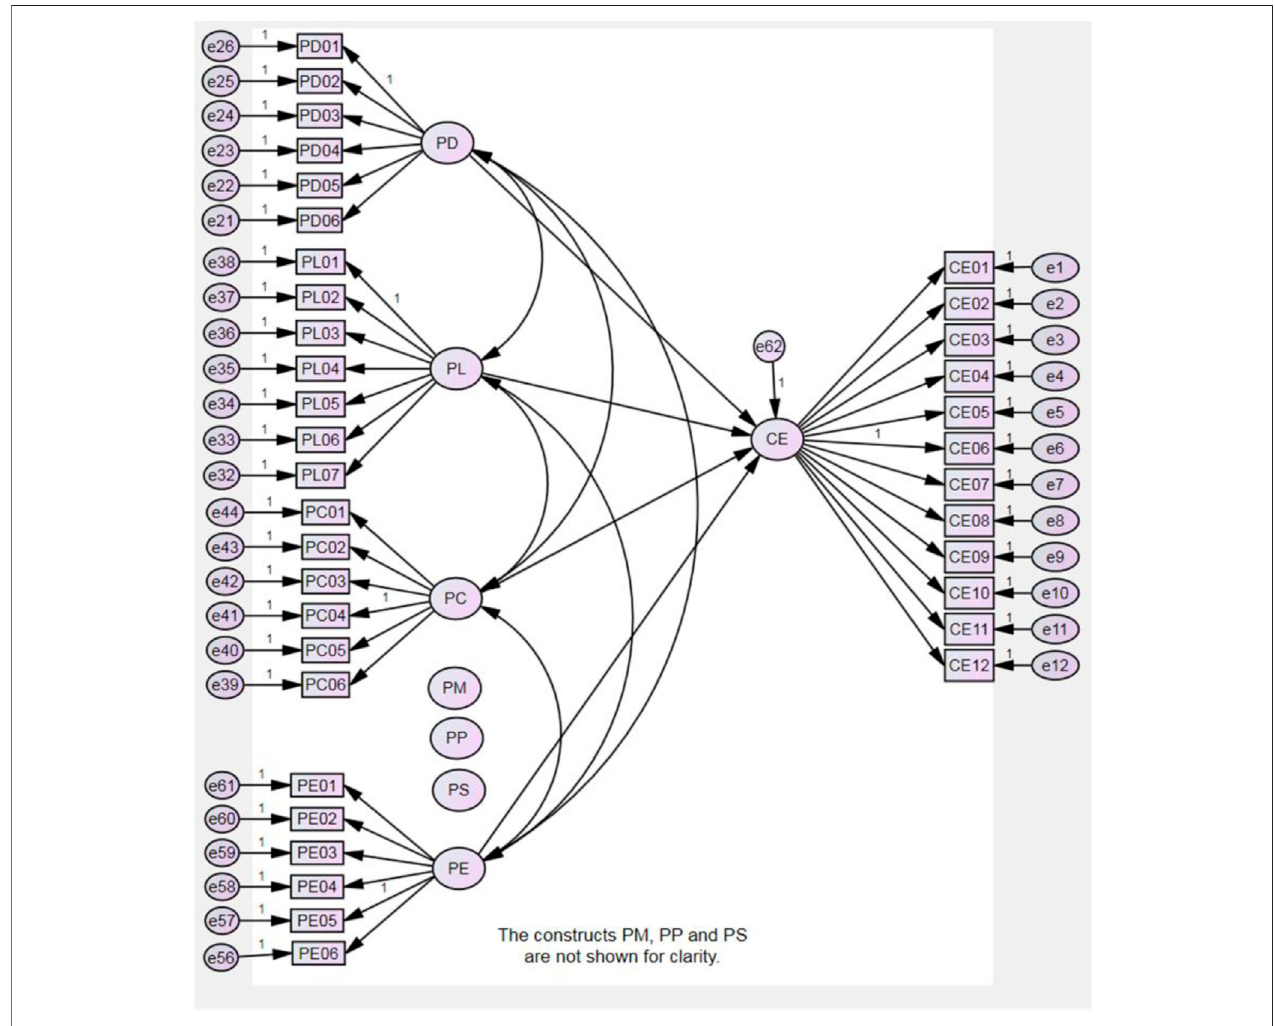
FIGURE 4 | Model construction for the